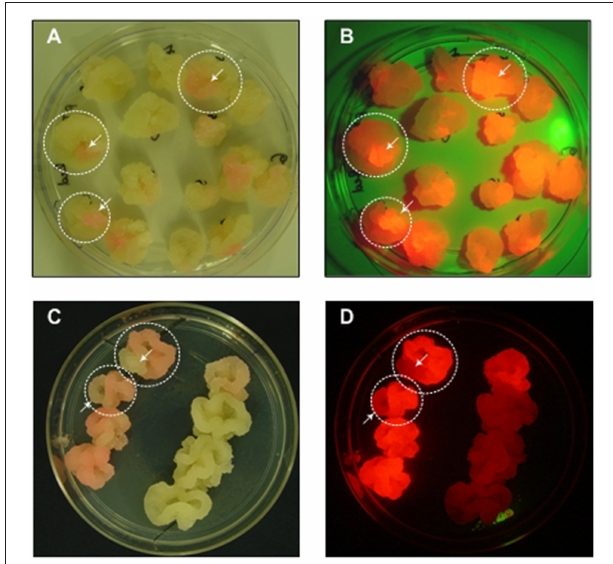
FIGURE 1 | Sectored callus cultures. (A,C) Images were taken under normal white light, (B,D) Images were taken under green light with a red filter for the macroscopic visualization of DsRed